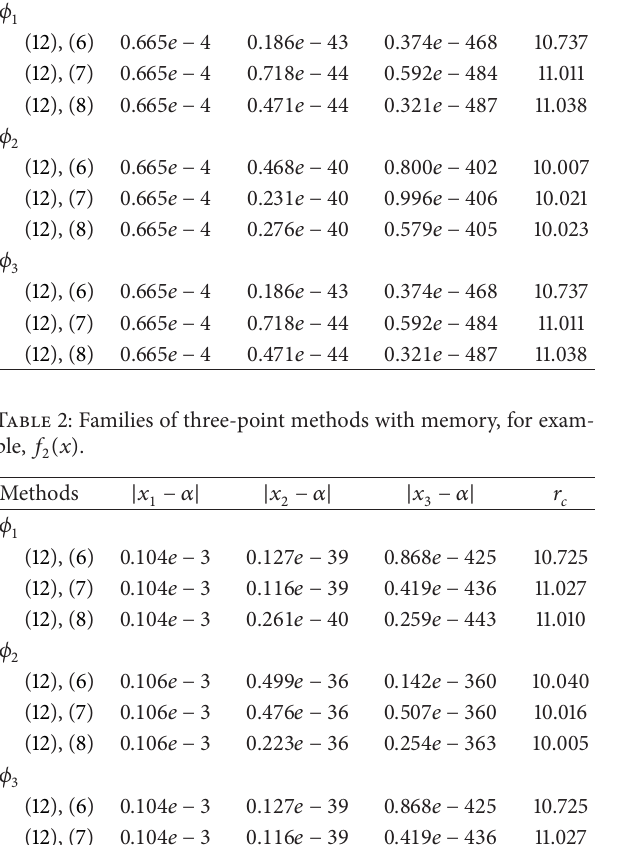
Table1:Familiesofthree-pointmethodswithmemory,forexample, (𝑥) . 𝑓 1 Methods